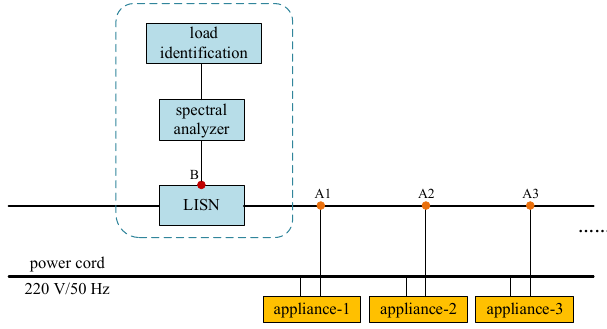
Figure 3. Schematic diagram of the measurement system. LISN, line impedance stabilization network.